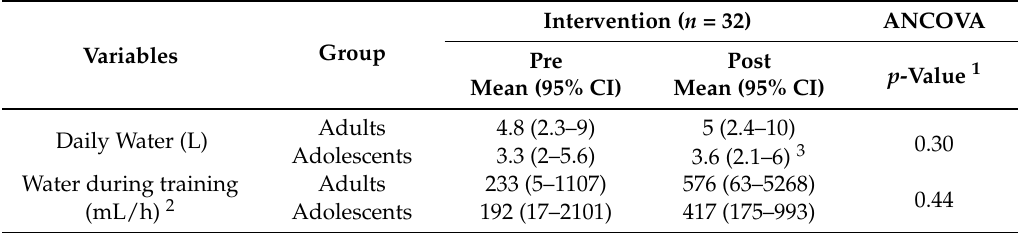
Table 2. Geometric mean (95% CI) of daily water intake and water ingestion during training.